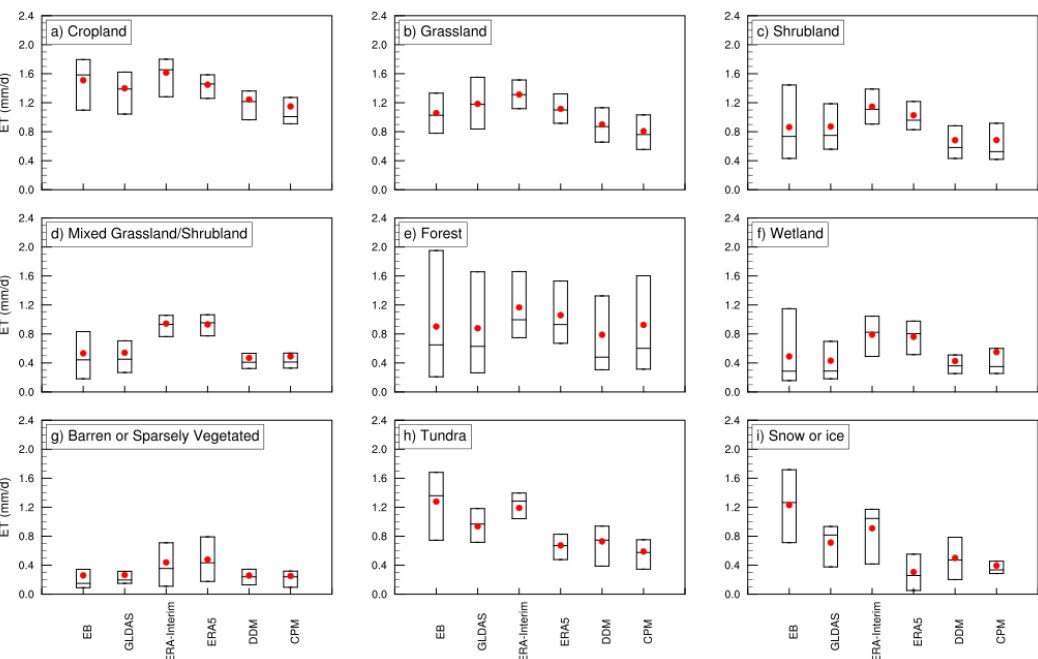
Figure 5. Box-and-whisker plots of ET of nine land-use categories based on six datasets averaged in 2014: ( a ) cropland; ( b ) grassland; ( c ) shrubland; ( d ) mixed grassland/shrubland; ( e ) forest; ( f ) wetland; ( g ) barren or sparsely vegetated; ( h ) tundra; ( i ) snow or ice (units: mm/d). The top and bottom of each box are the 20th and 80th percentiles in grid cells with the same land-use type. The lines in each box represent the median; red dots represent the mean.